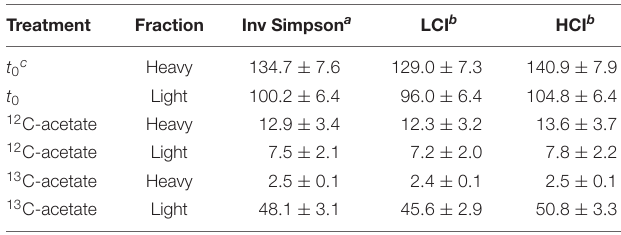
TABLE 3 | Inverse Simpson values for bacterial 16S rRNA amplicon sequences. Mean values of biological replicates with standard deviation. Treatment